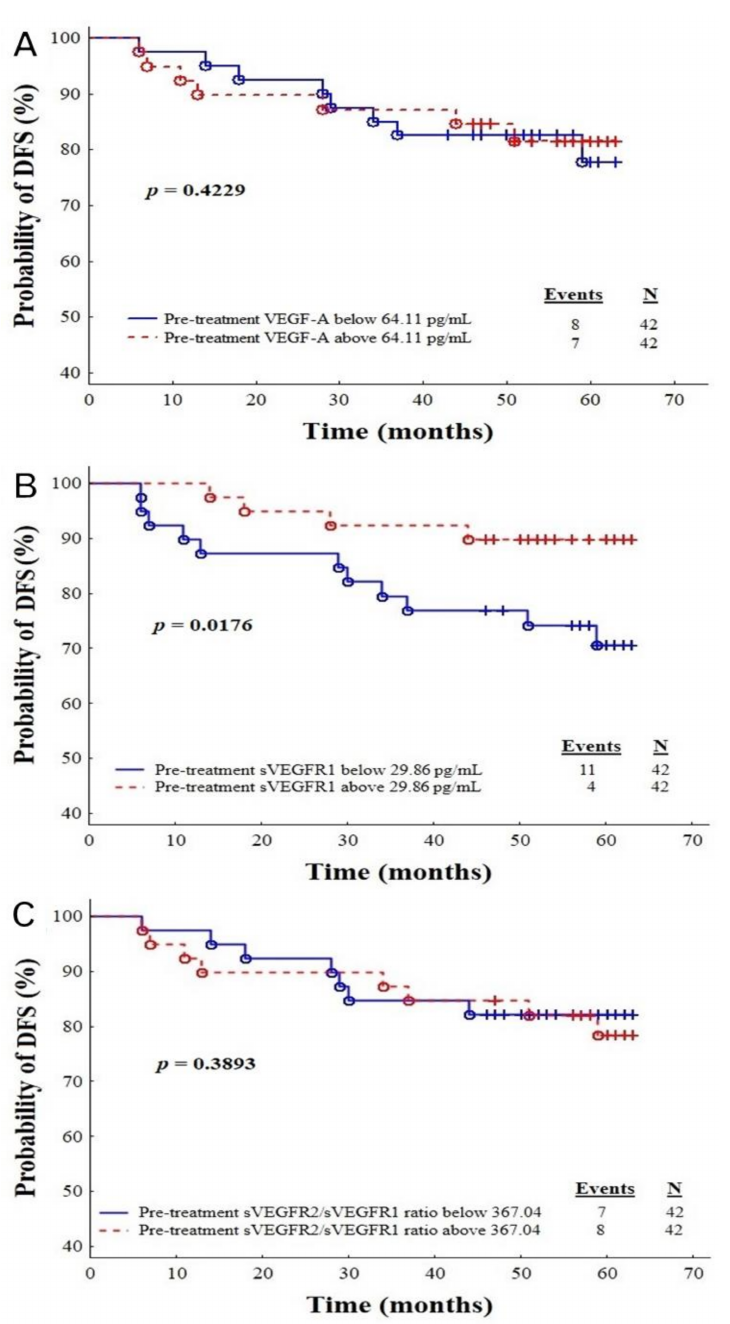
Figure 4. Plots C-E: Kaplan–Meier survival curves showing pre-treatment plasma VEGF-A ( A ), plasma sVEGFR1 ( B ) and sVEGFR2/sVEGFR1 ratio ( C ) in IBrC patients, divided according to cut-offs: for VEGF-A, <64.11 and >64.11 pg/mL; sVEGFR1, <29.86 and >29.86 pg/mL and sVEGFR2/sVEGFR1 ratios, <367.04 and